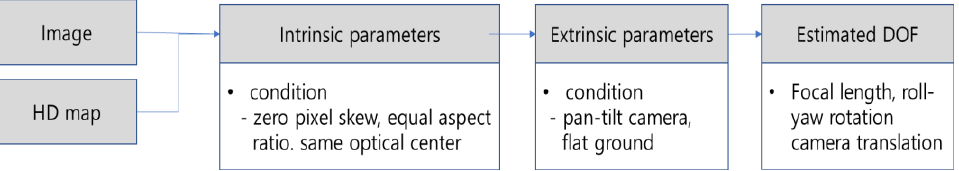
Figure 5. Corresponding points of two heterogeneous coordinate systems. To check the transformation relationship between the two coordinate systems with different dimensions in the traffic surveillance camera image and visualization, a trans- formation matrix was constructed using a point on the world coordinate system that matches a specific point on the traffic surveillance camera image together with the intrin- sic and extrinsic parameters. A method of calculating and extracting a large number of invariant feature points from an image and mapping the corresponding feature points in the world coordinate system to calculate a transformation matrix such as a homography matrix (H) in which the transformation relationship between the two coordinate systems was established [30]. In the former case, the location matching accuracy may be high, but there is a disadvantage in that it is not easy to obtain internal and external parameters through actual measurement of a traffic surveillance camera. In the latter case, the accu- racy may be lower than that of the former, but it is advantageous in that the establishment of the transformation relationship is relatively simple and the positioning accuracy can be improved according to the precision of the corresponding feature point. In this study, the H 𝑖𝑗 calculation method was adopted and used for usefulness veri- fication from the coordinate of the i- th camera to the coordinate of the j- th camera. H is a